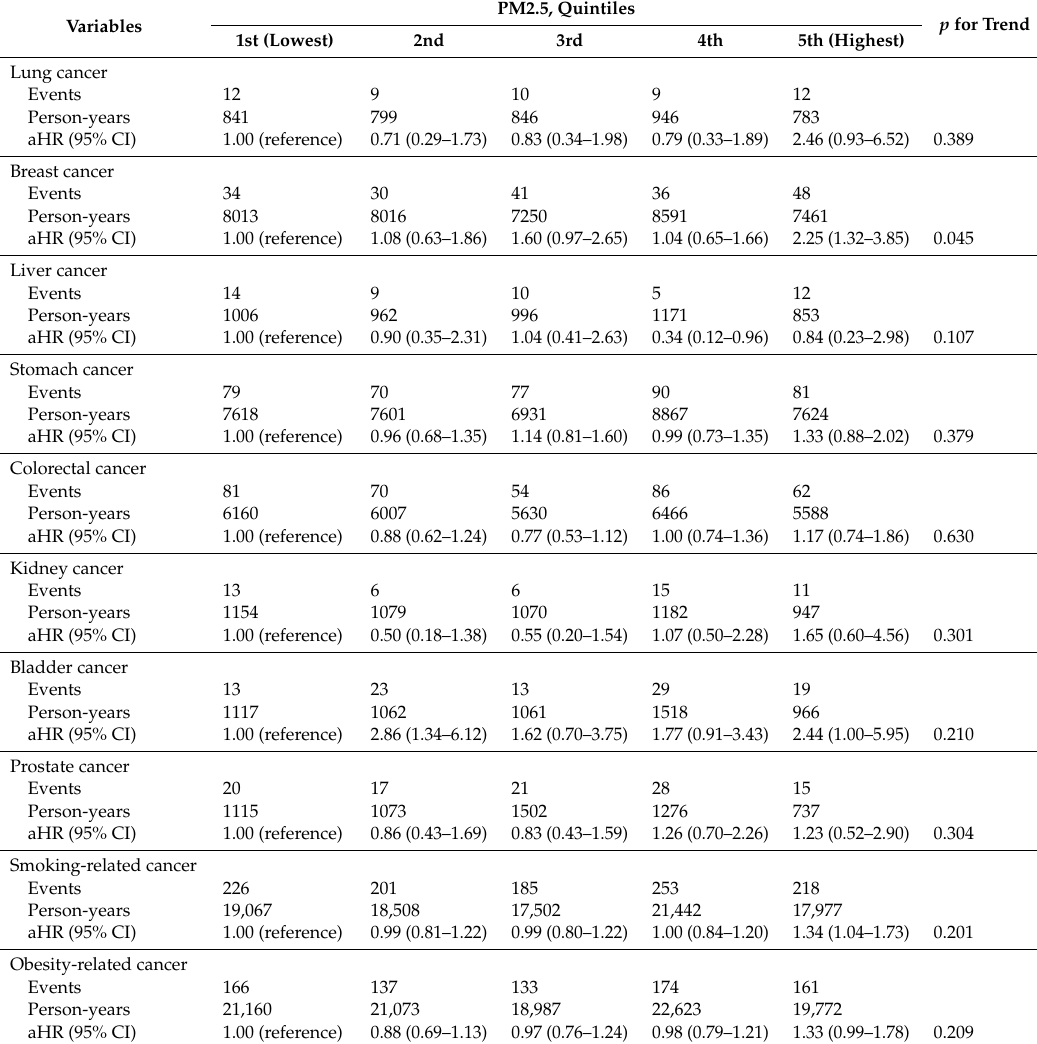
Table 5. Adjusted hazard ratios (95% CI) for cardiovascular disease according to post-diagnosis PM2.5–10 levels among 5-year cancer survivors in various cancer